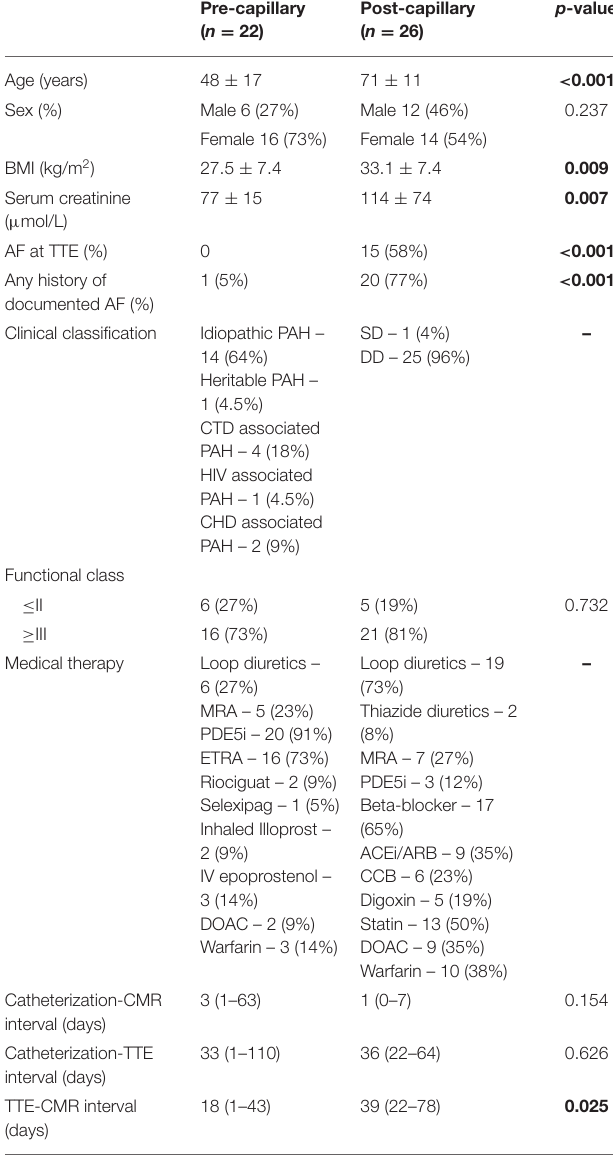
TABLE 1 | Baseline patient